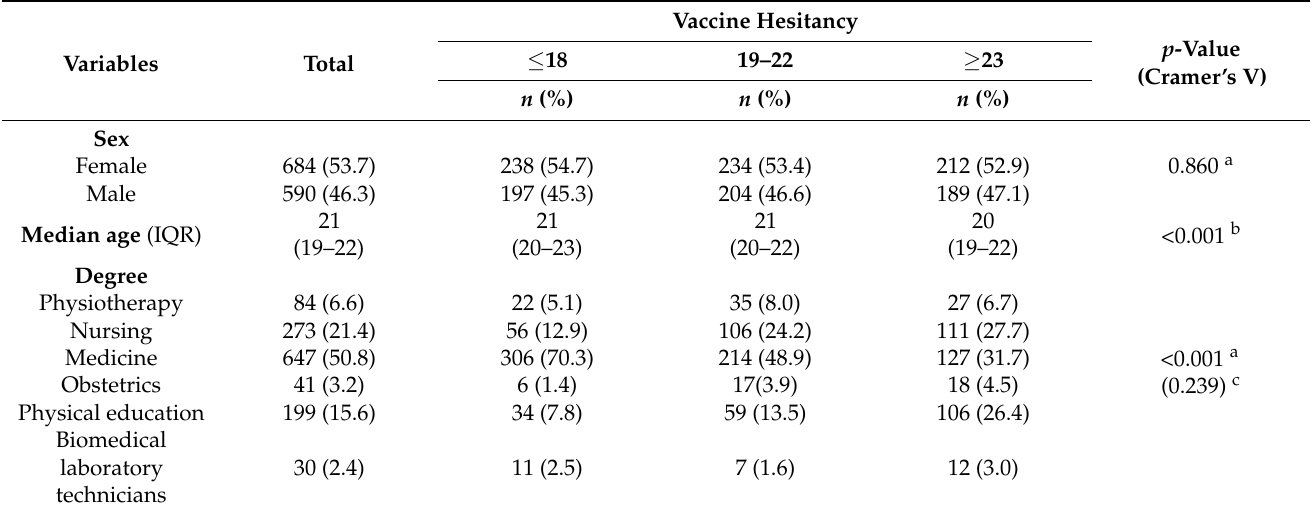
Table 1. Socio-demographic characteristics of the respondents ( n = 1275) by vaccine hesitancy